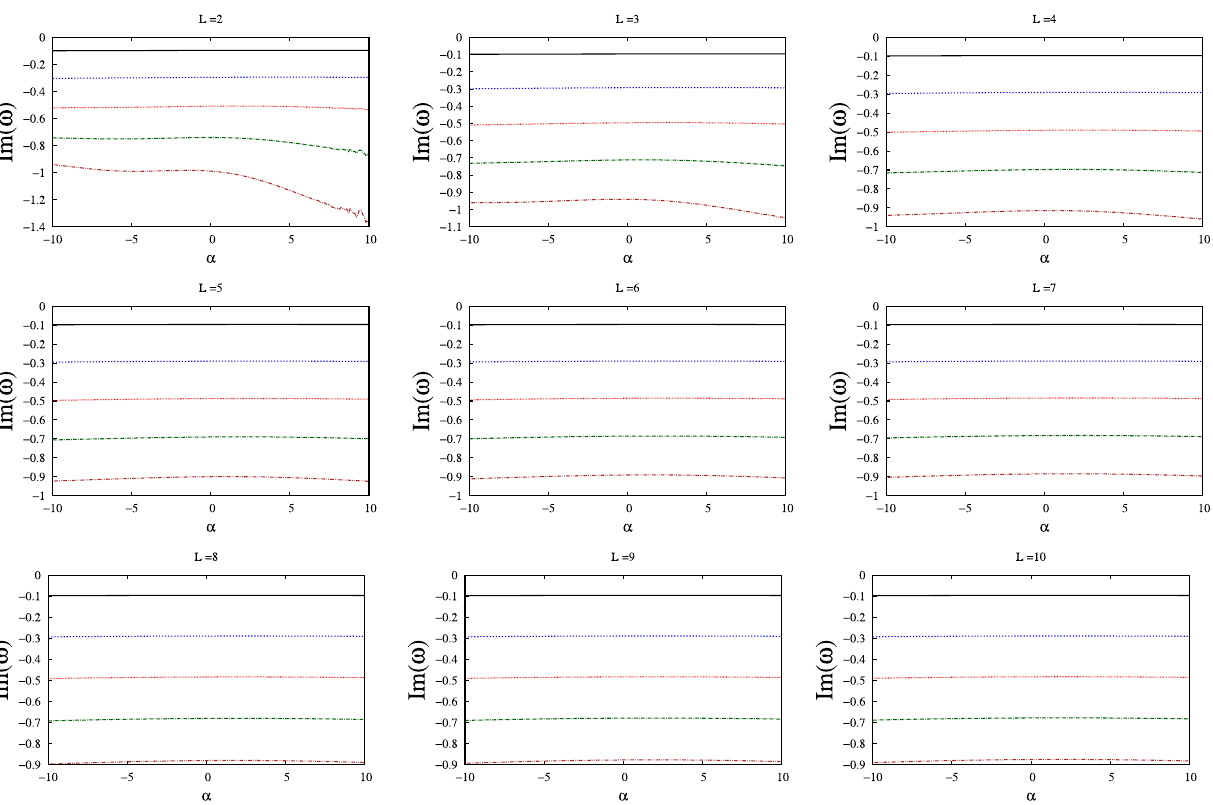
Fig. 3 Imaginary part of the QNM for Model 2 as a function of the hair α for different values of L and n . Each plot corresponds to a different value of L . The values for n are 0 (black line), 1 (blue line), 2 (red line), 3 (green line), 4 (brown